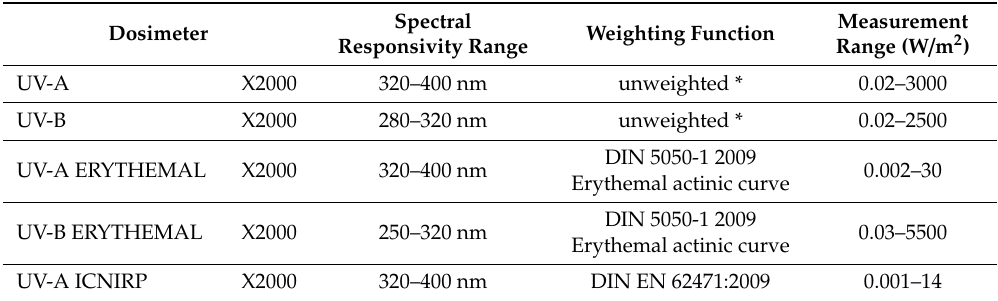
Table 1. Spectral responsivity of the electronic dosimeters used for the measurement campaign of individual UV exposure of the group of